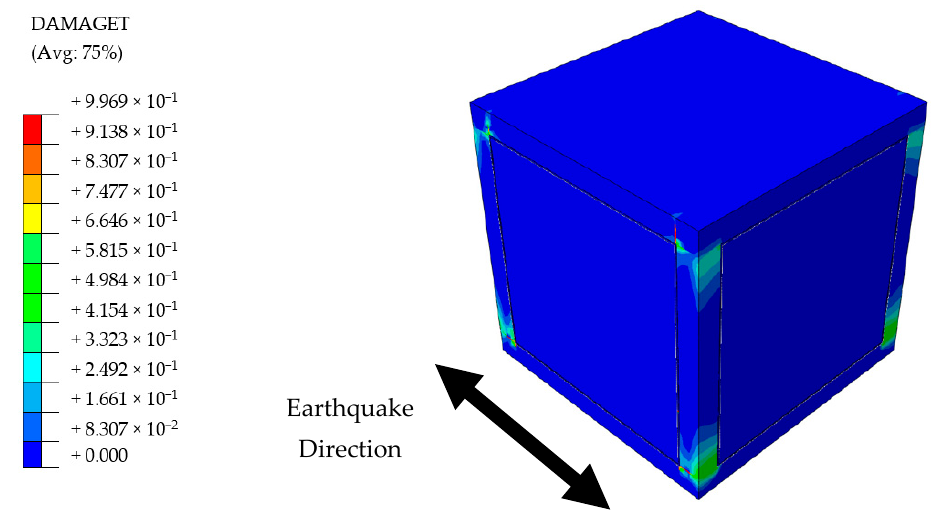
Figure 20. Damage distribution on the TM Building.